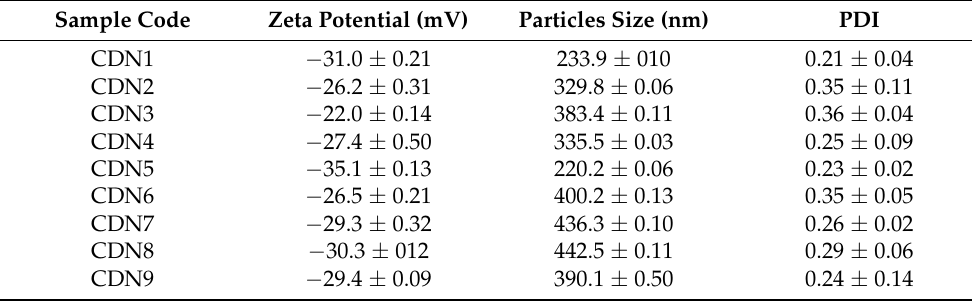
Table 3. Particle size, zeta potential, and PDI of nanovesicles (Mean ± SD, n = 5).